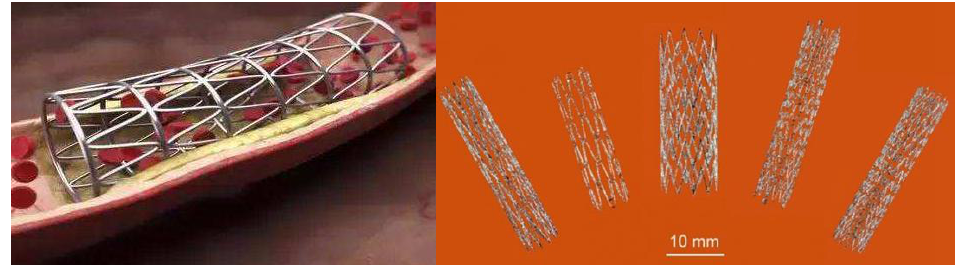
Figure 15. Application of Ni-Ti alloy vascular stent formed by SLM in vivo [44].